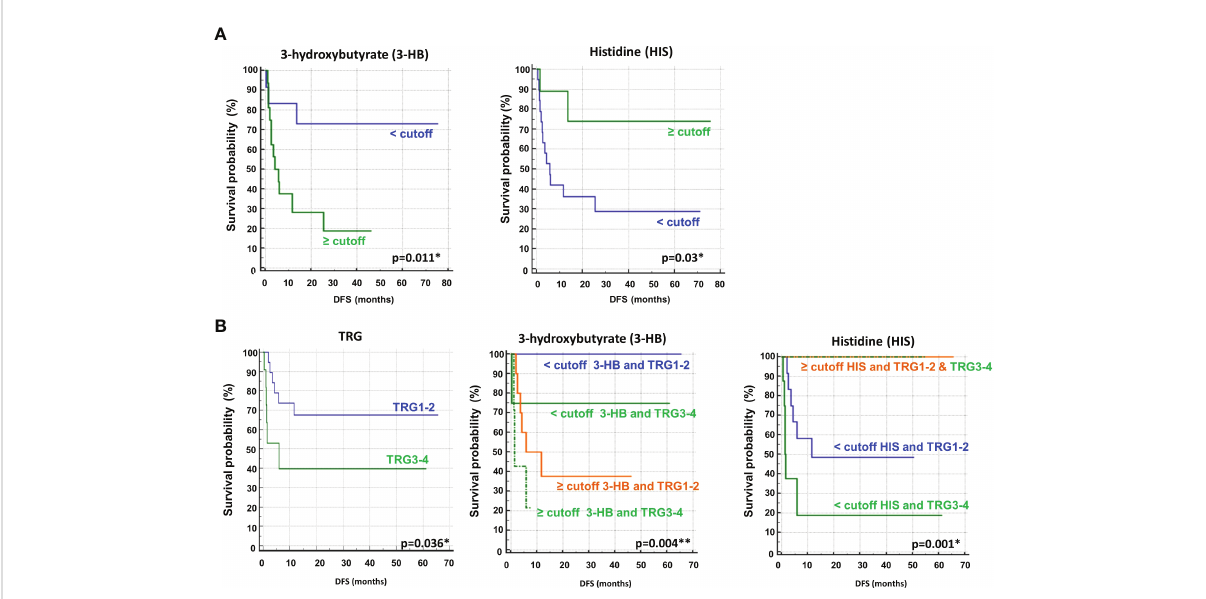
FIGURE 3 (A) Kaplan – Meier curves of disease free survival (DFS) accordingly to 3-hydroxybutyrate (3-HB) and histidine (HIS) (B) Kaplan – Meier curves of DFS accordingly to tumor regression grade (TRG) alone or in combination with either 3-HB or HIS. Log-rank p-values are reported. * and ** symbols indicate p-values < 0.05 and < 0.01,